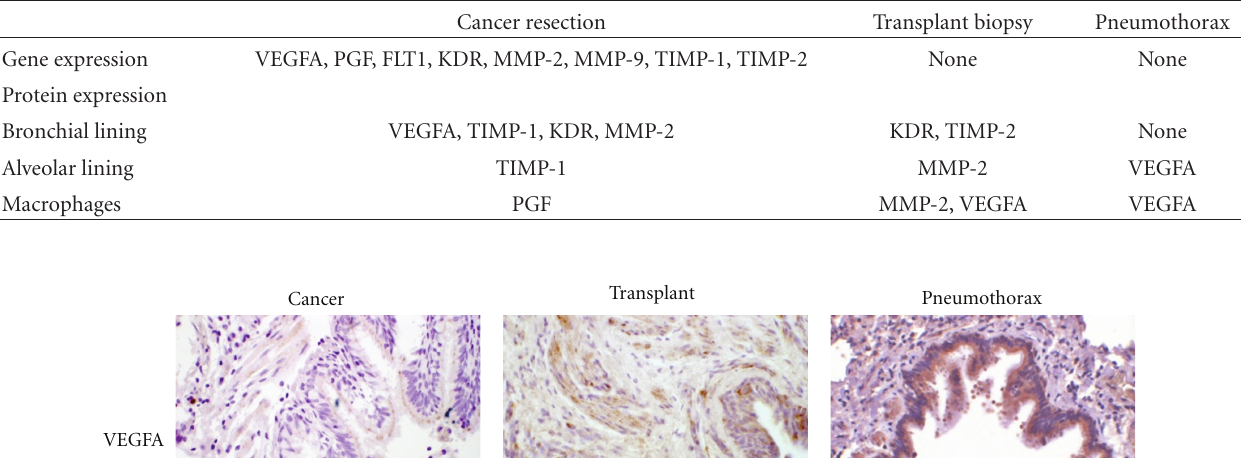
Table 4: Biomarkers unsuitable for gene and protein expression studies in cancer resection, transplant biopsy, and pneumothorax.